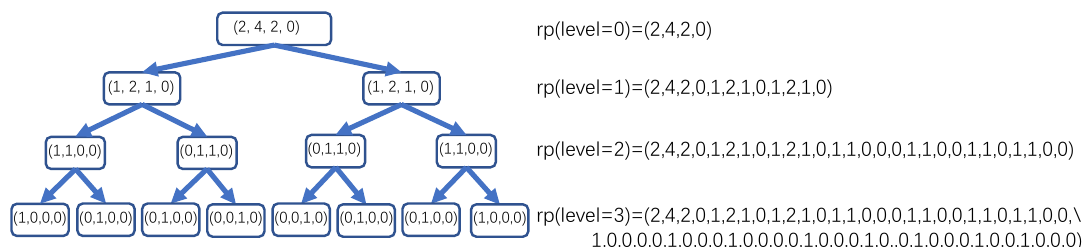
Figure 4. An example for BDT-based representation